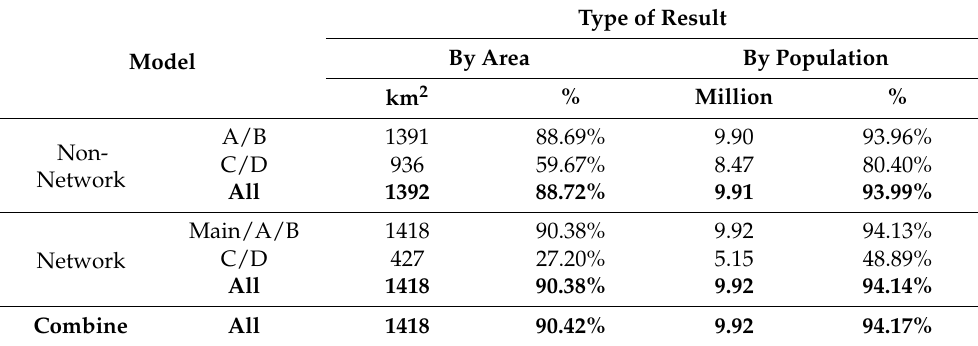
Table 3. GIS results by model.